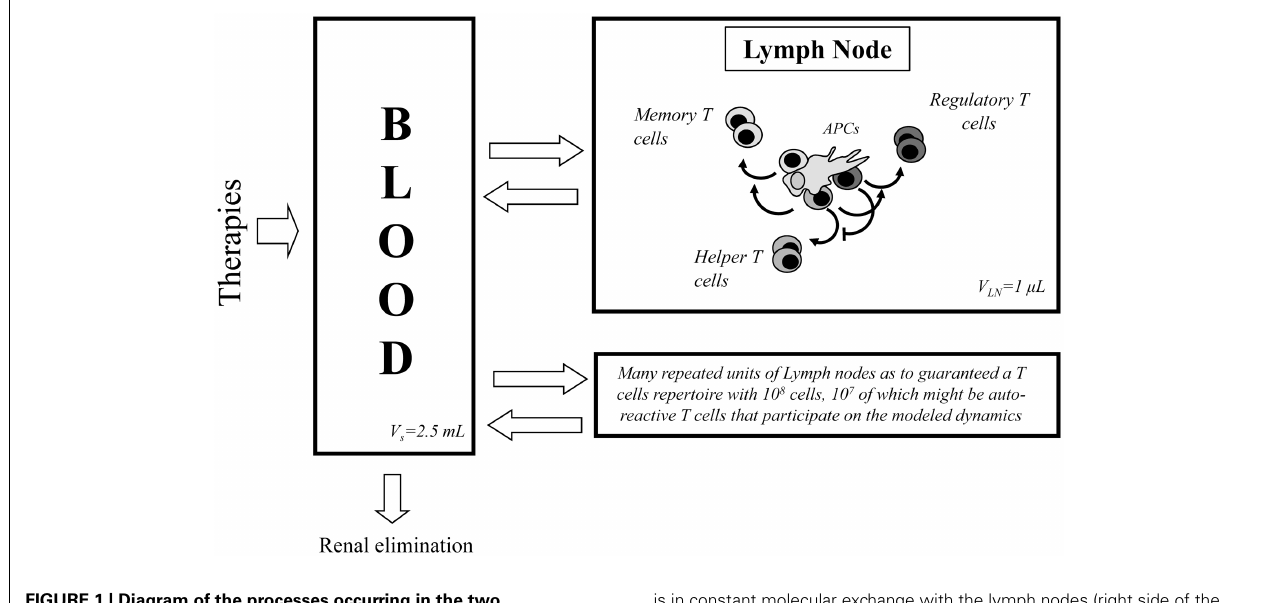
FIGURE 1 | Diagram of the processes occurring in the two compartments considered in the model . At the left side of the diagram the blood compartment is shown, where soluble molecules related with IL2 modulatory therapies are introduced and eliminated.This compartment